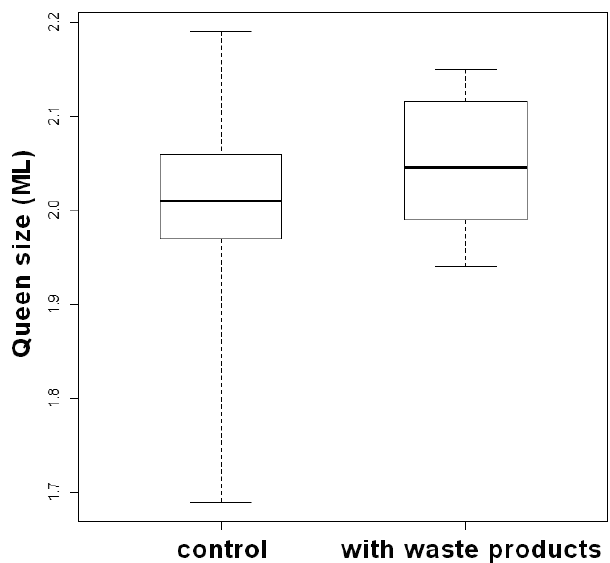
Figure 2. Variation in median queen size (mesosoma length in mm) between control plots and plots with waste products in Myrmica rubra . Difference is statistically insignificant. Whiskers of the boxplot represents the range of minimum and maximum